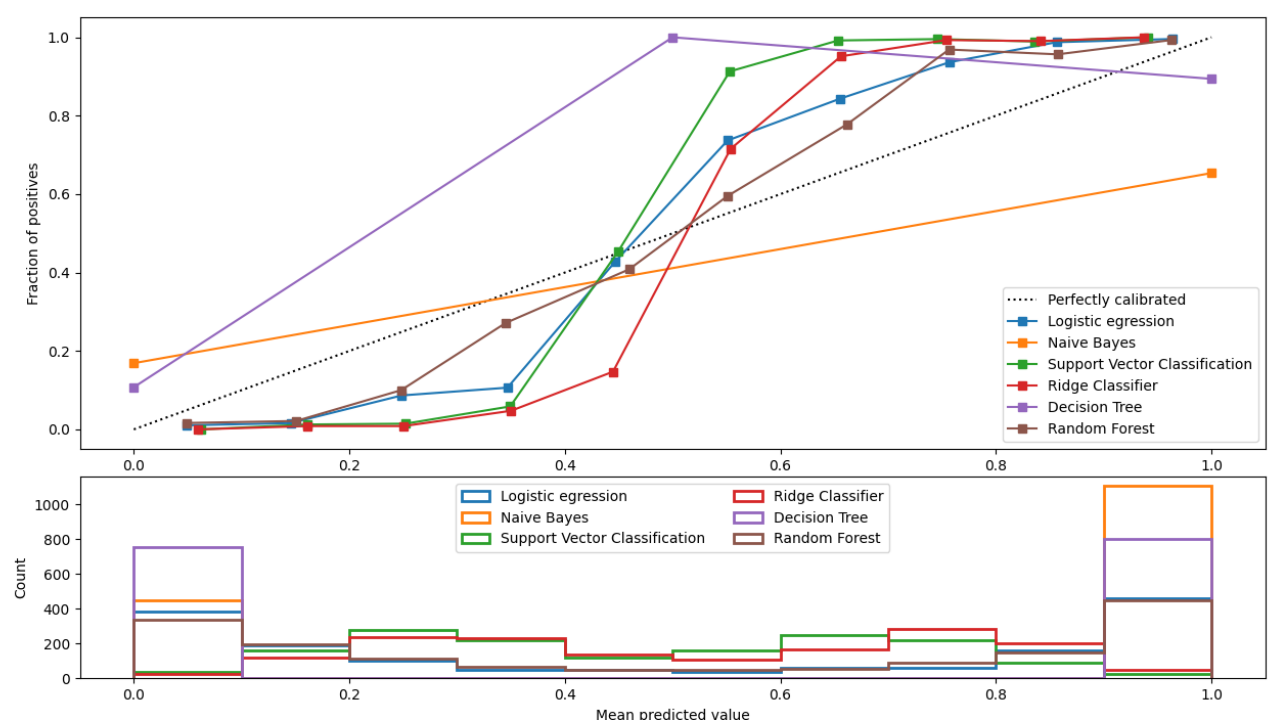
Figure 6. Default hyperparameters.